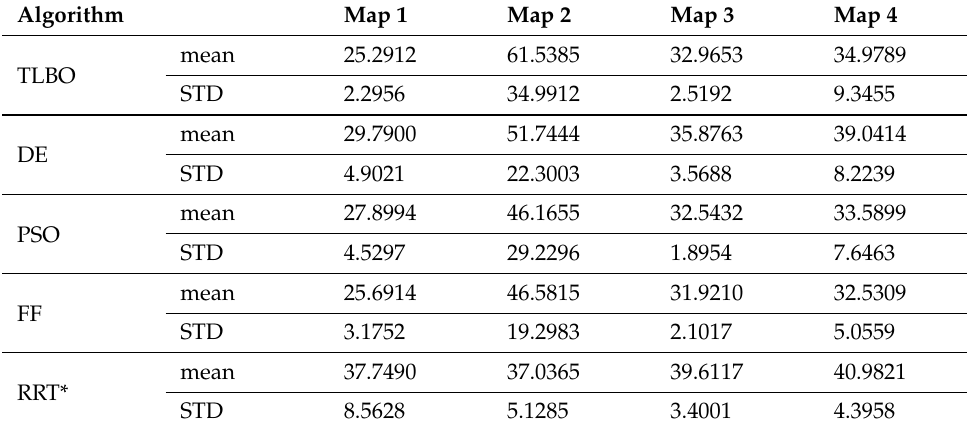
Table 3. Experimental results, mean and standard deviation of the distance of the found path for each